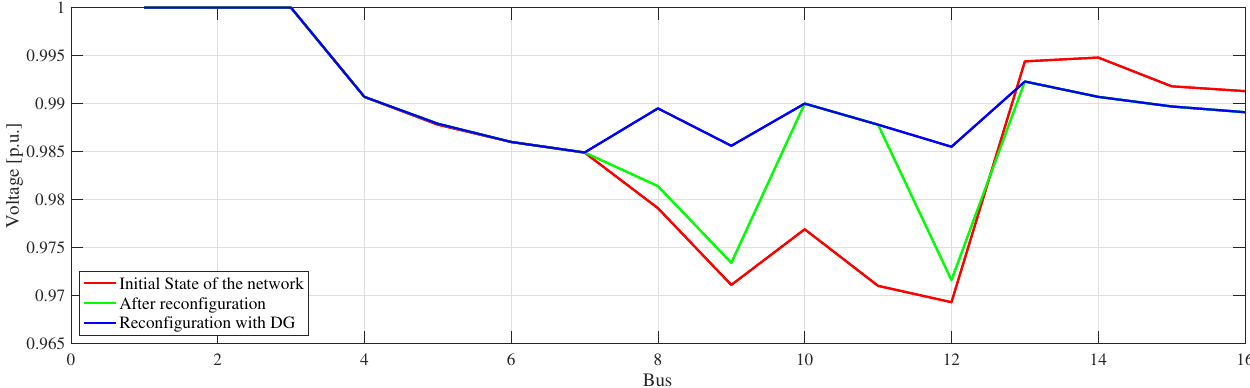
Figure 2. Voltage profile of the 16-bus test